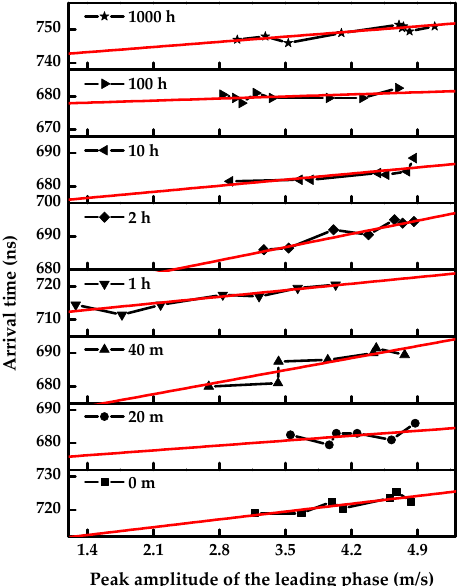
Figure 5. Variations in the end-time of the leading phase of the particle velocity profile in detected acoustic pulses as a function of the detected amplitude of this phase. Straight red lines provide the best linear fits for experimental points.